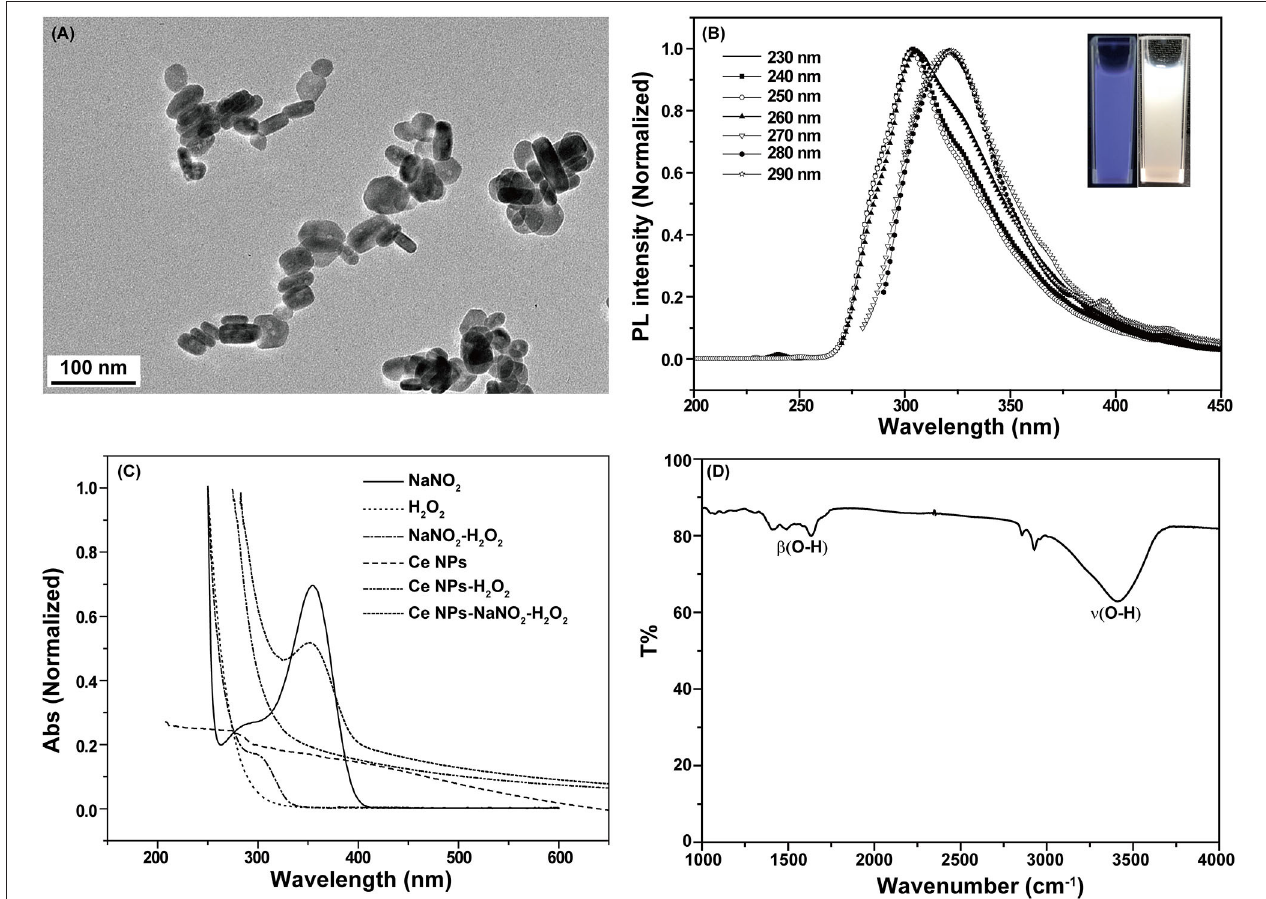
FIGURE 1 | Characterization of LaF 3 :Ce NPs. (A) Transmission electron microscopy images of LaF 3 :Ce NPs. (B) PL spectra of LaF 3 :Ce NPs. The inset is the photograph of LaF 3 :Ce NPs under a UV lamp ( λ ex = 254nm). (C) UV-vis absorption spectra of the reagent in the CL reaction. (D) FT-IR spectra of LaF 3 :Ce